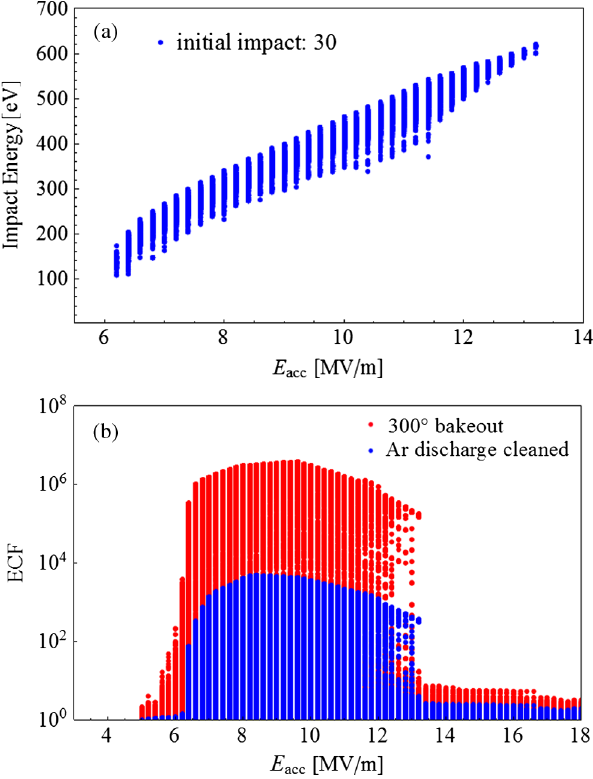
FIG. 9. Characteristics of zone 1 MP in the HOM coupler of a CEBAF upgrade cavity: (a) electron impact energy; (b) ECF after 20 rf